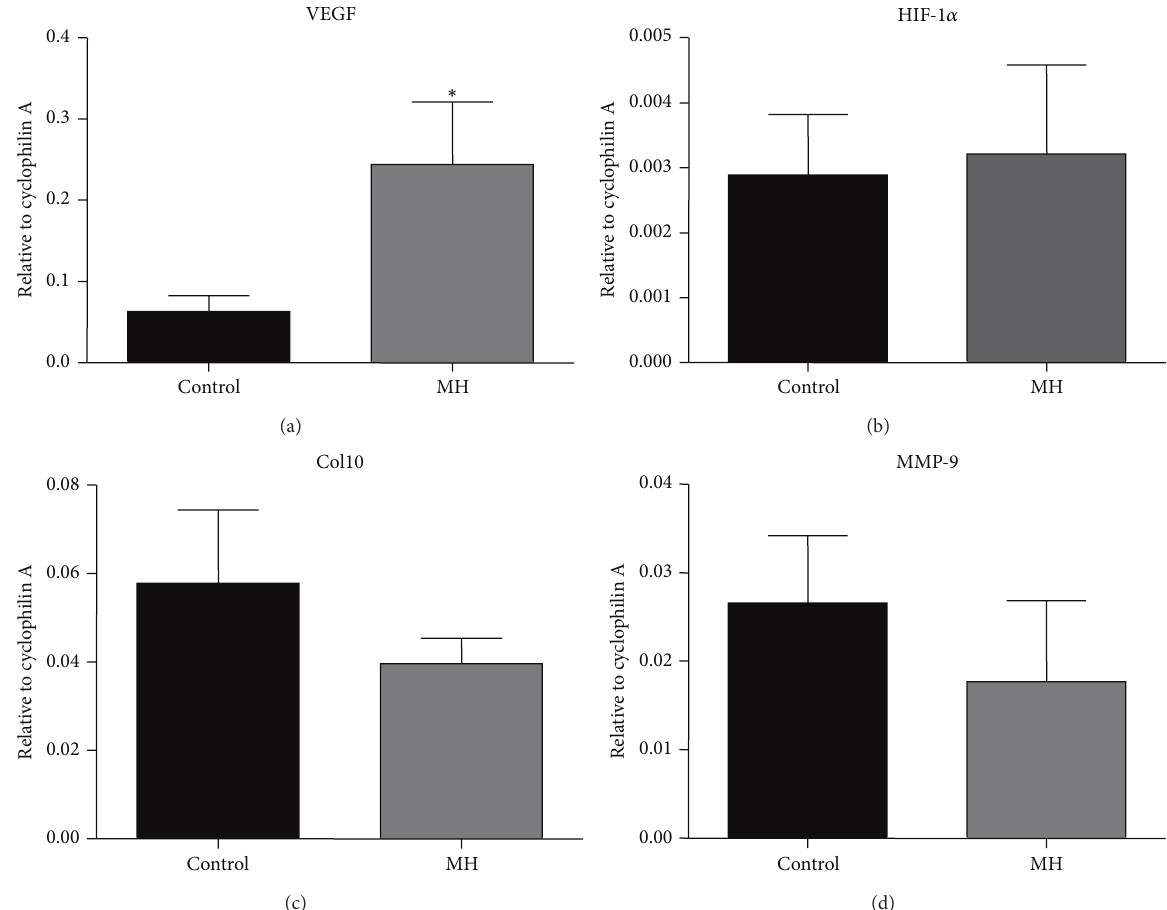
Figure 2: Effects of MH on mRNA expression of genes in growth plate in the postnatal offspring. Quantitative real-time RT-PCR expression data for VEGF (a), HIF-1 𝛼 (b), Col10 (c), and MMP-9 (d) are expressed as relative to internal standard cyclophilin A. ∗ 𝑃 < 0.05 when compared to